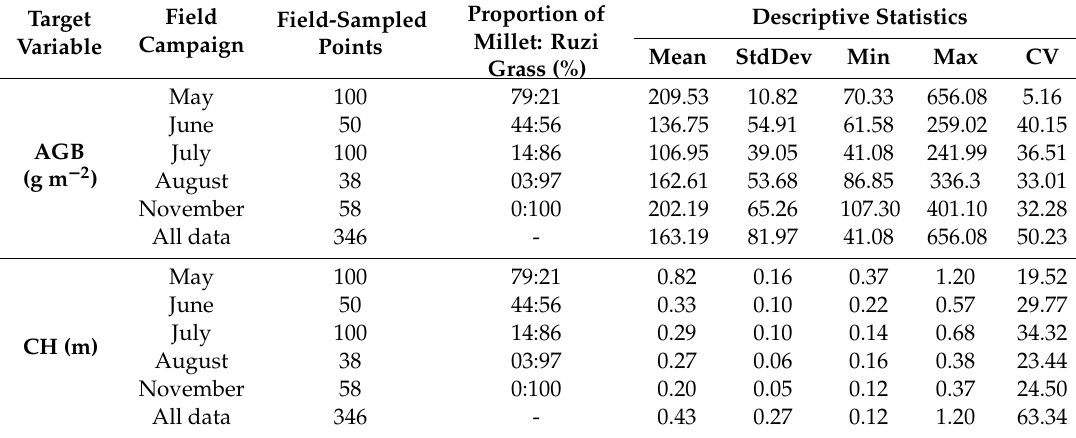
Table 1. Descriptive statistics of the pasture aboveground biomass (AGB) and canopy height (CH) for the field